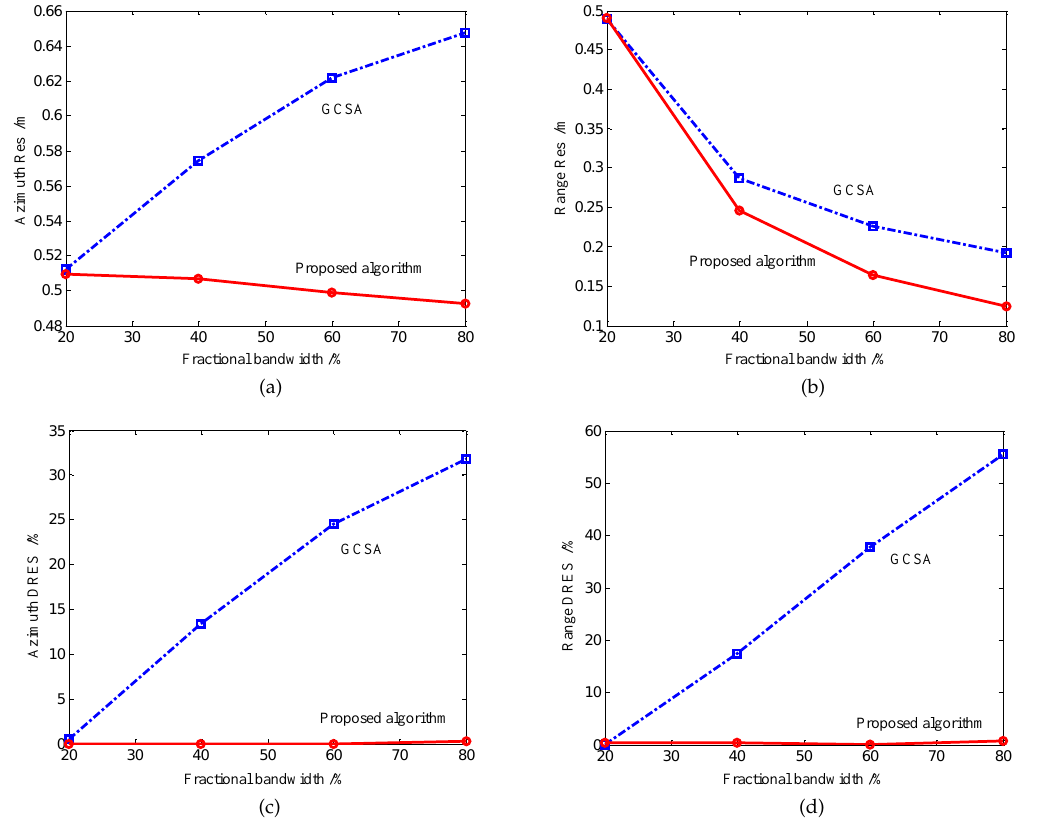
Figure 8. Resolutions (Res) and differential resolutions (DRES) in azimuth and range given by the generalized chirp scaling algorithm (GCSA) and proposed algorithm, where the resolutions obtained by ω − k algorithm are references. ( a ) Azimuth Res. ( b ) Range Res. ( c ) Azimuth DRES. ( d ) Range